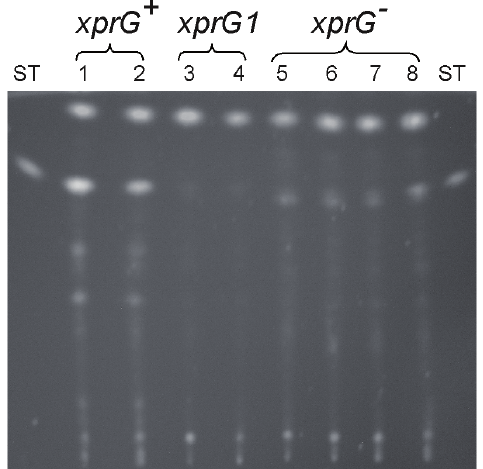
Supplementary Figure 2. Sterigmatocystin extracted from cultures grown on solid medium . Samples of two xprG + strains (lane 1 MH2, Lane 2 MH97), two xprG1 strains (lane 3 MK85, lane 4 MK86) and four xprG - strains (lane 5 MK198, lane 6 MK413, lane 7 MK414, lane 8 MK422) was analyzed using thin layer chromatography with a benzene: glacial acetic acid (95:5 vol/vol) as described in the experimental procedures. A sterigmatocystin (ST) standard (Sigma) was applied as standard.